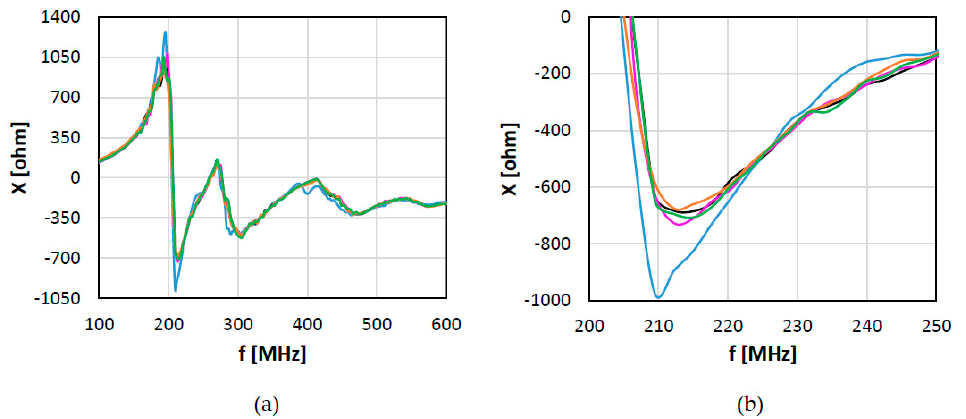
Figure 5. Spectra of X ( a ) and values of the minimum peak in the restricted range considered for the measurements ( b ), for water ( – ) and water–NaCl mixtures with NaCl molar fraction of 2.3 × 10 − 4 (–), 4.5 × 10 − 4 (–), 1.35 × 10 − 3 (–), and 1.8 × 10 − 3 ( – ).